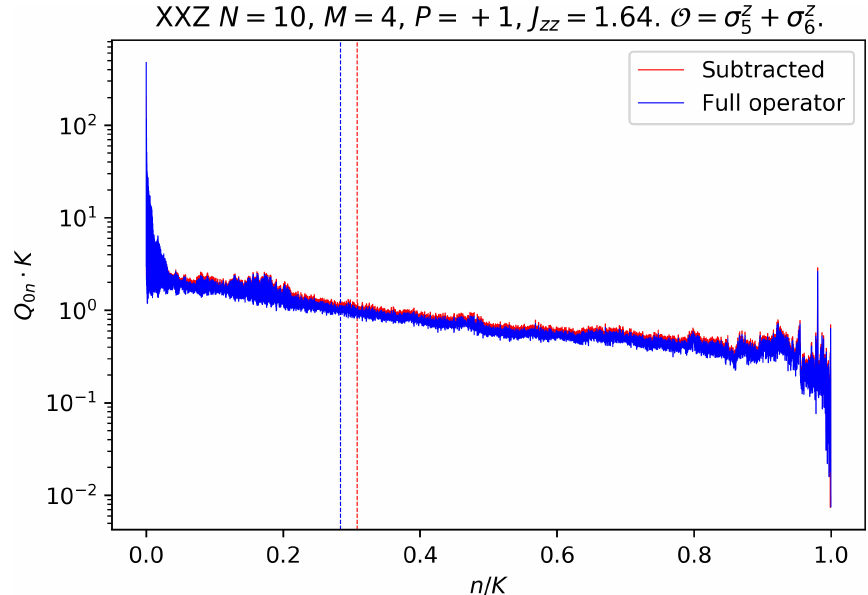
Figure 11. Long-time averaged transition probabilities for an instance of XXZ studied in [7], this time also considering a version of the operator where the non-vanishing one-point function has been subtracted. In contrast to the cSYK case, this time the subtraction of the one-point function 4 doesn’t alter drastically the K-complexity saturation value, since in this case undersaturation is due to the monotonously decaying profile of Q that we associated to Anderson localization on the 0 n Krylov chain in [7], together with the fact that even the connected part of the two-point function is itself not exponentially suppressed at late times due to the integrable nature of the